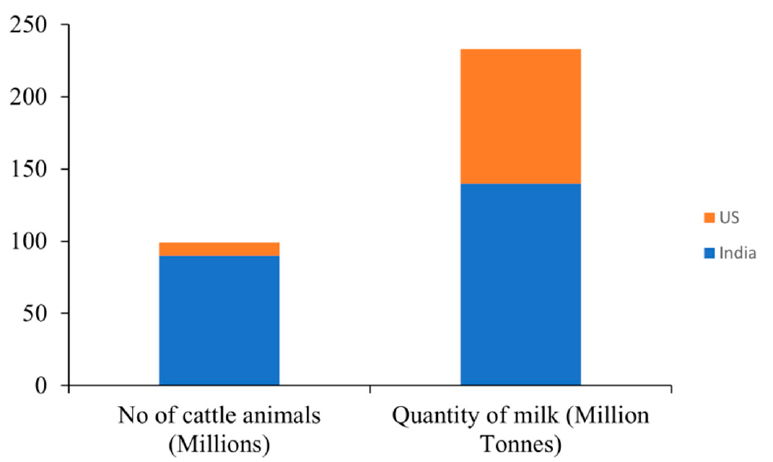
Figure 1. Statistics of Milk Productivity.